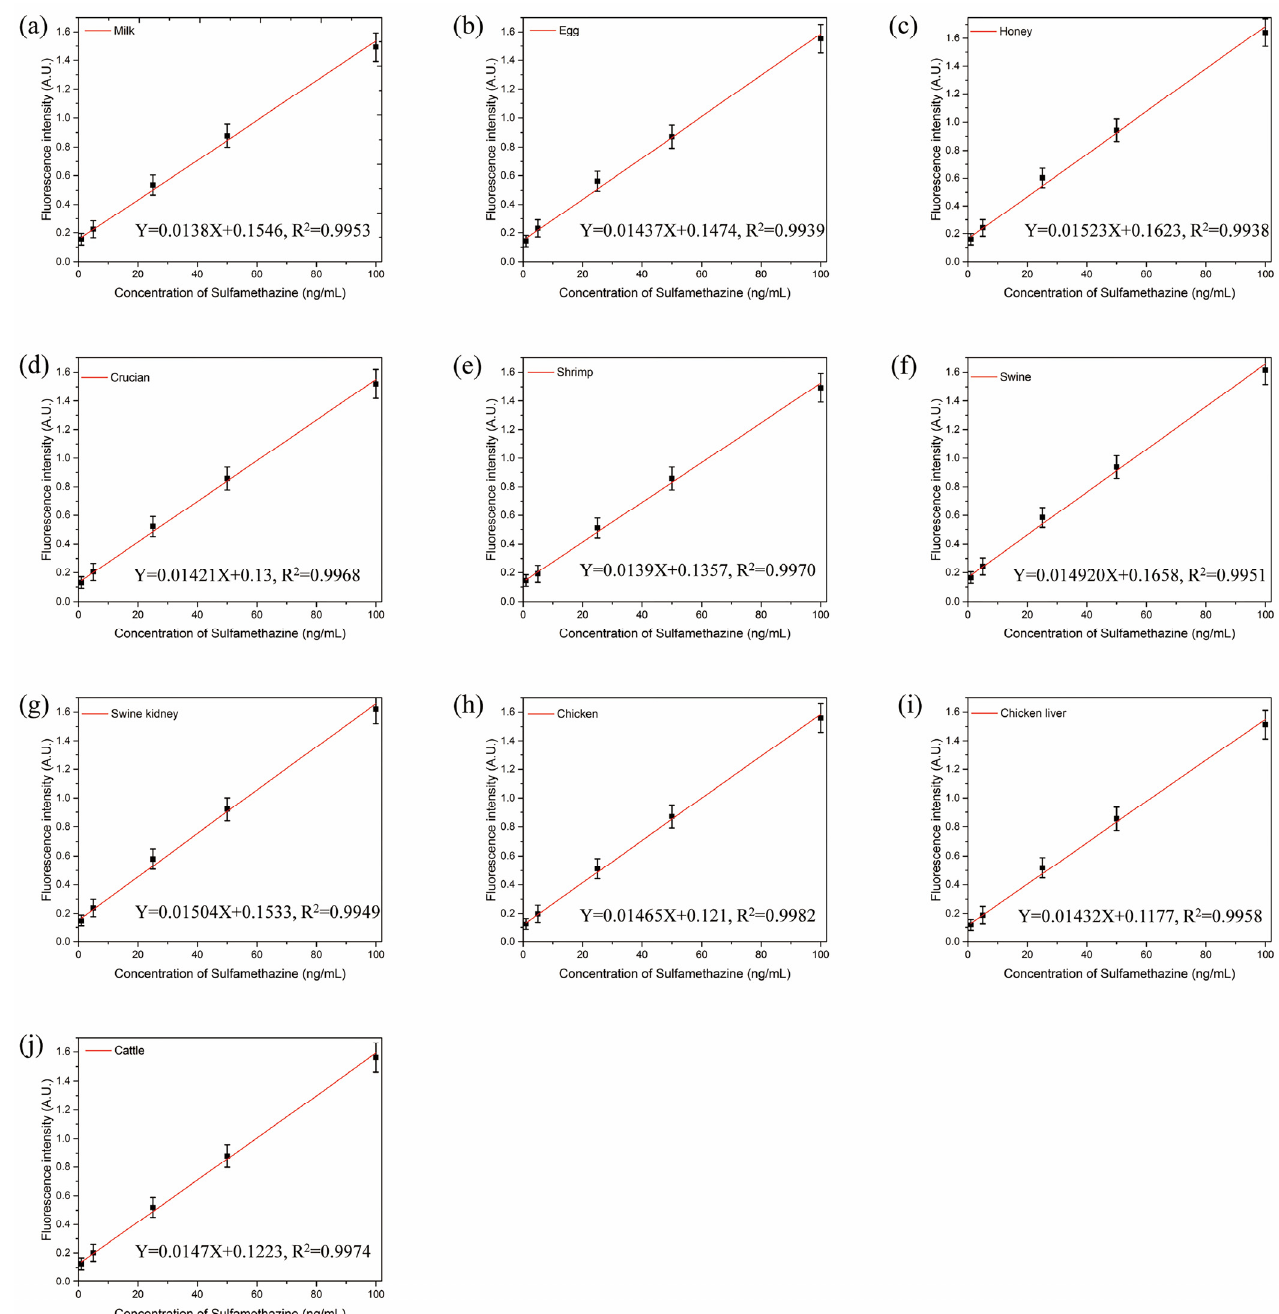
Figure 6. Standard curves corresponding to detection in food matrix, including ( a ) milk, ( b ) egg, ( c ) honey, ( d ) crucian, ( e ) shrimp, ( f ) swine, ( g ) swine kidney, ( h ) chicken, ( i ) chicken liver and ( j ) cattle.